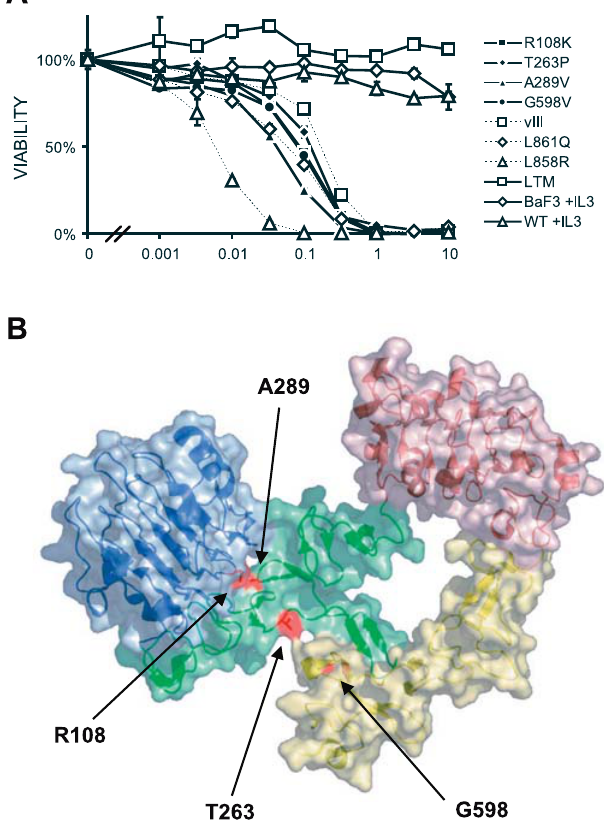
Figure 4. EGFR Missense Mutations Sensitize Cells to EGFR Kinase Inhibitors (A) Effect of increasing concentrations of the EGFR inhibitor erlotinib (0– 10 l M) on the viability of IL-3 independent Ba/F3 subclones expressing EGFR ectodomain mutants (R108K, T263P, A289V, G598V, and EGFRvIII), the EGFR kinase domain mutants (L858R and L861Q), or the erlotinib- resistant EGFR double mutant L858R-T790M (LTM). Parental Ba/F3 cells and Ba/F3 cells expressing wild-type EGFR are not IL-3 independent and were included as controls. Viability (a mean percent of control 6 standard deviation) was determined after exposure to erlotinib for 48 h. (B) Oncogenic EGFR ectodomain mutations map to interdomain interfaces. Shown are ribbon and surface diagrams of the EGFR [46] with sites of amino acid substitutions highlighted. Blue, domain I; green, domain II; red, domain III; and yellow, domain IV. Sites of the most prevalent amino acid substitutions are shown in red. Images were created with PyMOL (http://pymol.sourceforge.net/). P596 is not visible in this view.